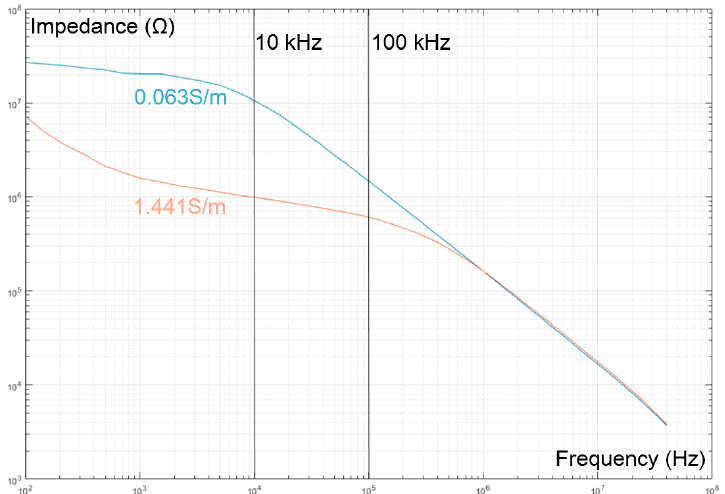
Figure 3. Experimental results of 4 different KCl concentrations in a